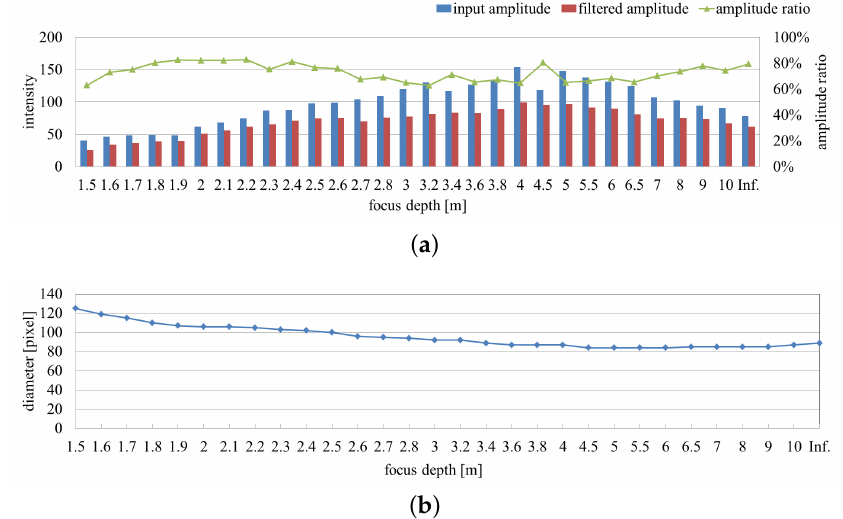
Figure 7. Averaged amplitudes and extracted region sizes with focus distance variation. ( a ) Averaged amplitudes of input and pixel-wise filtered images and their ratios on the extracted pixels; ( b ) diameters of extracted vibration